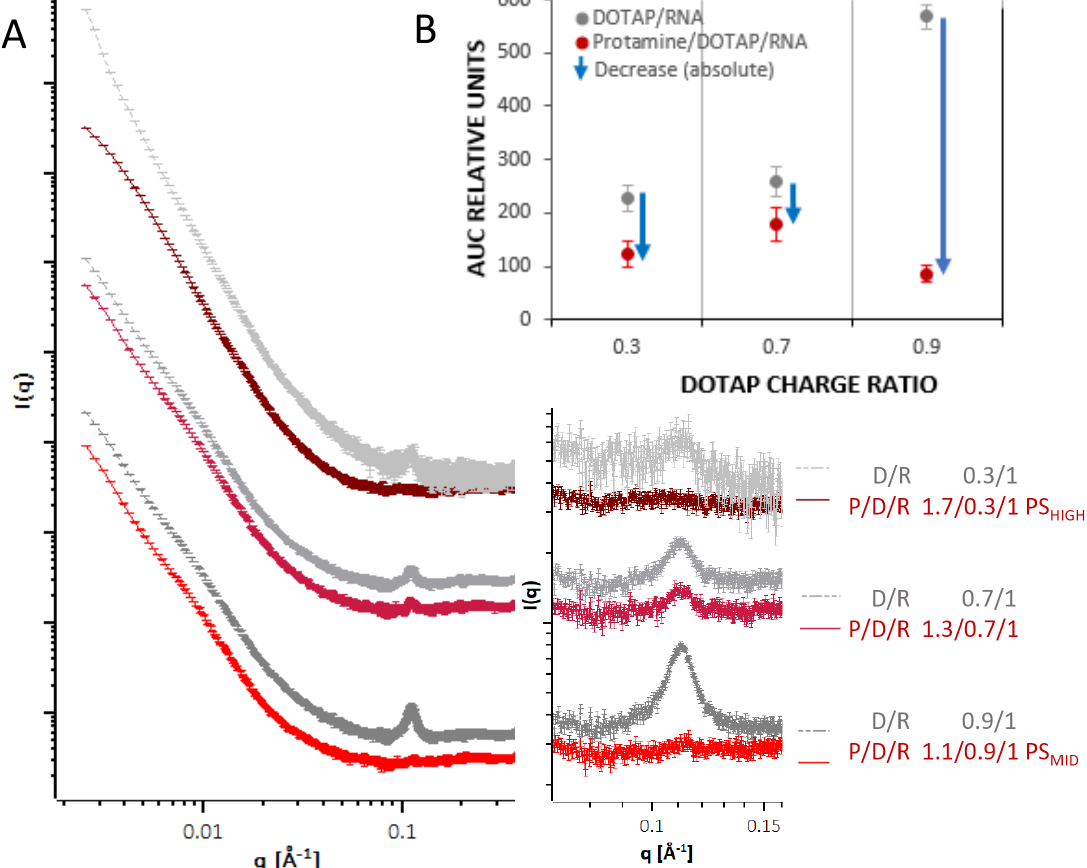
Figure 3. ( A ) Double logarithmic plot of SAXS profiles of negatively charged PS particle intermediates (DOTAP/RNA, grey curves) of three different charge ratios of DOTAP (0.3, 0.7, 0.9) with a constant charge ratio of RNA (1.0) and for each curve below the corresponding curve after protamine addition to form the final PS particle (red curves) in HBG buffer (pH 7.2). Colour darkening indicates a higher proportion of protamine in the particle for the red curves and of DOTAP in the grey curves. The magnification shows the q-range around 0.11 Å − 1 where the peak is located. Curves were shifted vertically for clarity. ( B ) Area under the curve (AUC) for the three different N/P ratios. The blue arrow indicates the absolute reduction of the AUCs after protamine addition.